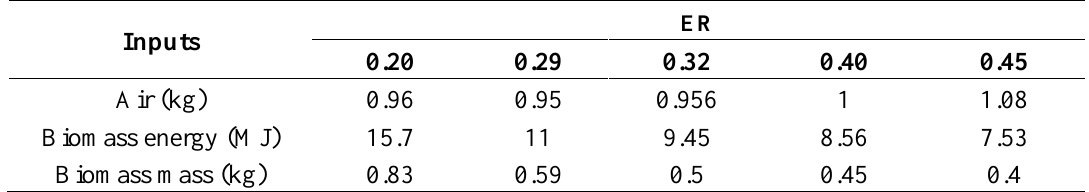
Table 6. Variations in inputs for producing 1 m 3 syngas (adapted with modification from [29]). ER: equivalence ratio.